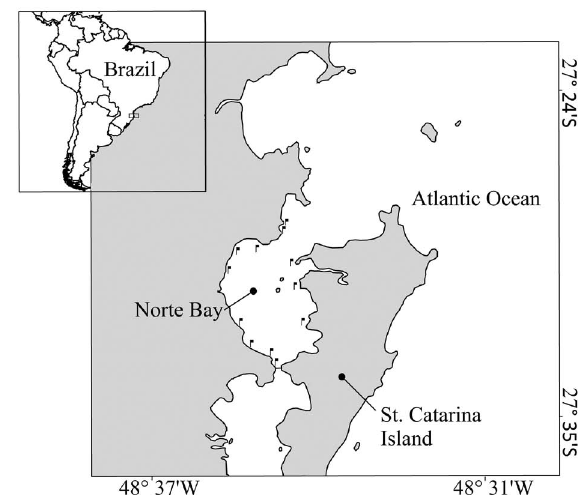
Fig . 1. – Geographic locations of Norte Bay and the stranded Guiana dolphins (flags indicate only the stranded dolphins with exact loca- tions